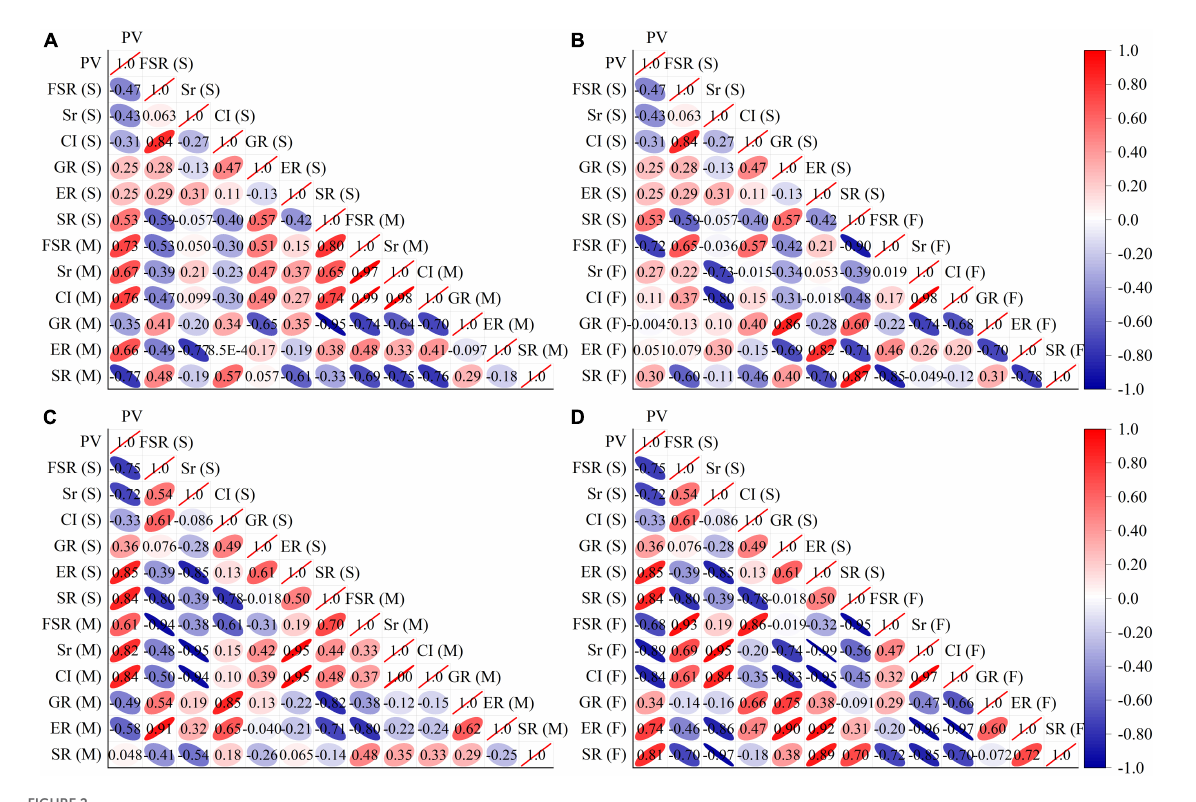
FIGURE2 Correlation analysis of fertility indexes. (A) Shows the results of the correlation analysis between the fertility of selfing and the fertility of hybrid male parents for the experiments performed in 2020. (B) Shows the results of the correlation analysis between the fertility of selfing and the fertility of the hybrid female parent in 2020. (C) Shows the results of the correlation analysis between the fertility of selfing and the fertility of hybrid male parents in 2021. (D) Shows the results of the correlation analysis between the fertility of selfing and the fertility of the hybrid female parent in 2021. PV, FSR, Sr, CI, GR, ER, and SR represent fertility indexes of pollen viability, fruit-setting rate, seediness rate, compatibility index, germination rate, emergence rate, and seedling rate. (s) Cultivar as selfed, (M) Cultivars as male parent, (F) Cultivars as female parent.